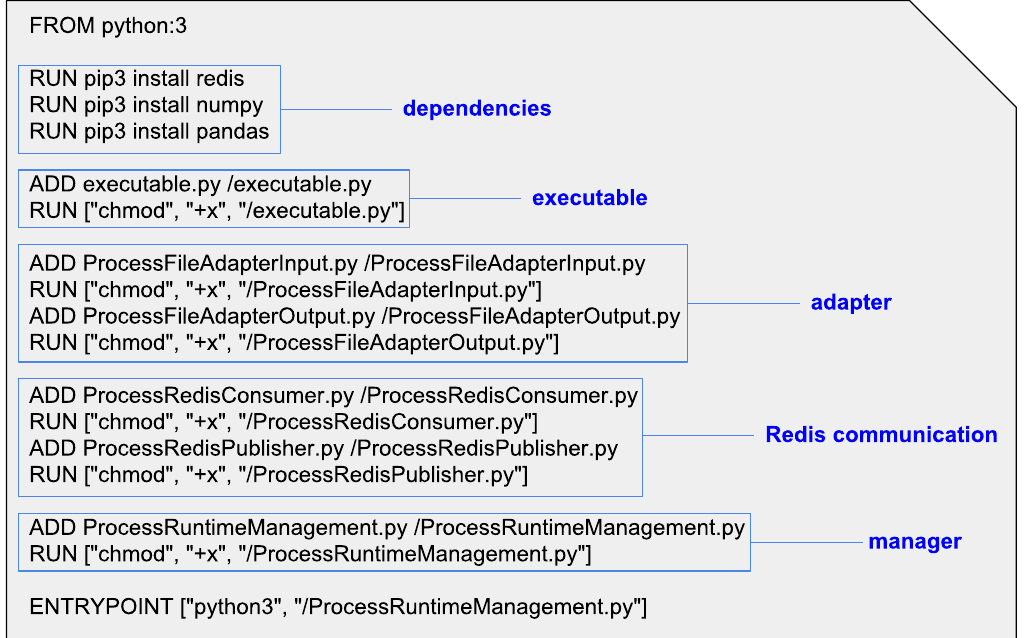
Figure 11. Structure of a Dockerfile for the creation of a custom workflow using the presented